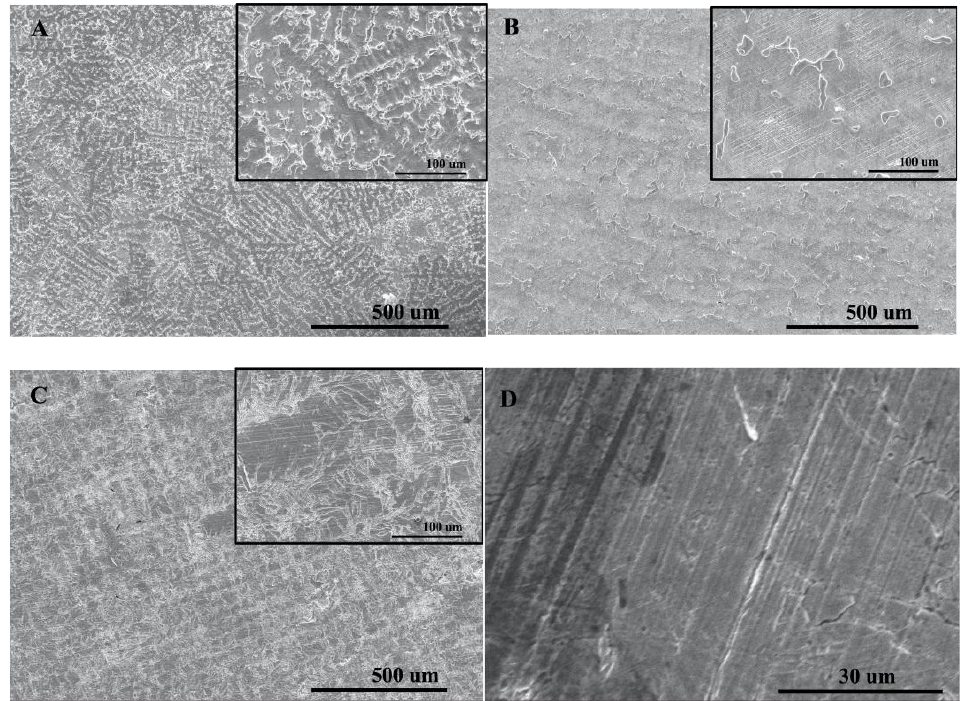
Figure 7. SEM images from polished section of Co-Cr alloys. ( A ) casting (original magnification × 100 and magnification of inserts × 500), ( B ) milling (original magnification × 100 and magnification of inserts × 500), ( C ) SLM (original magnification × 100 and magnification of inserts × 500). ( D ) SLM specimen (original magnification ×